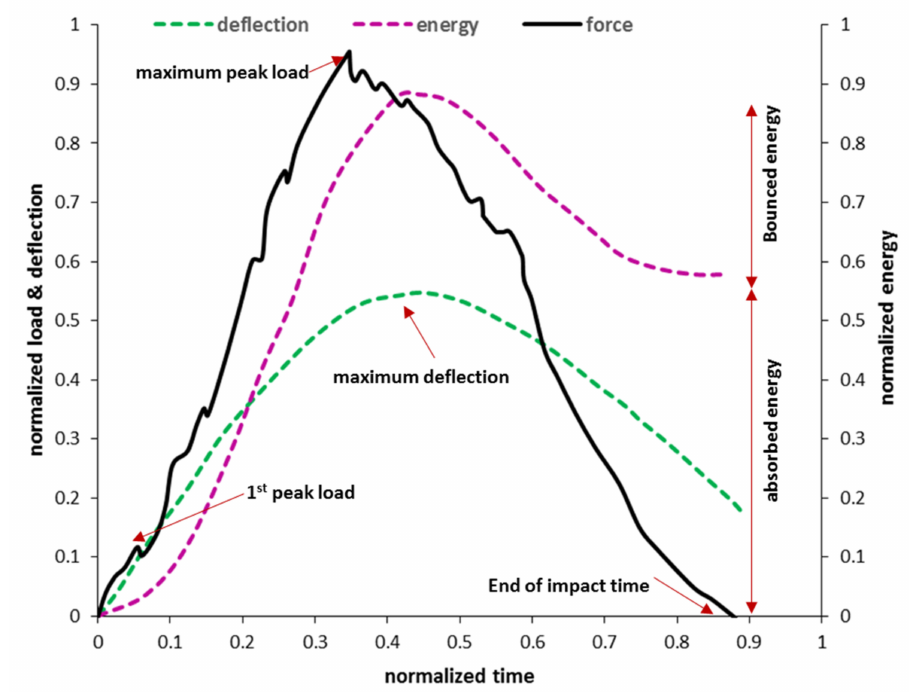
Figure 4. A schematic plot for load, deflection, and energy as a function of time [148].